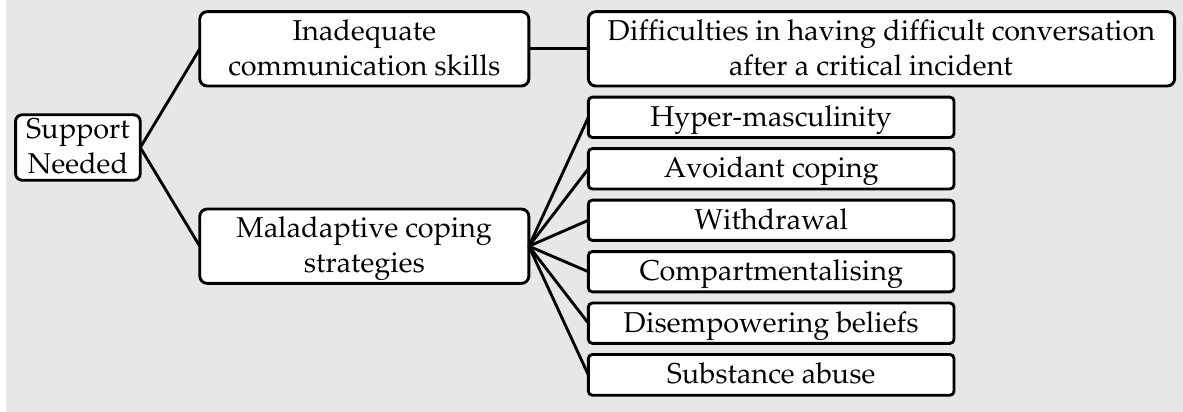
Figure 3. Trusted others’ support needs.